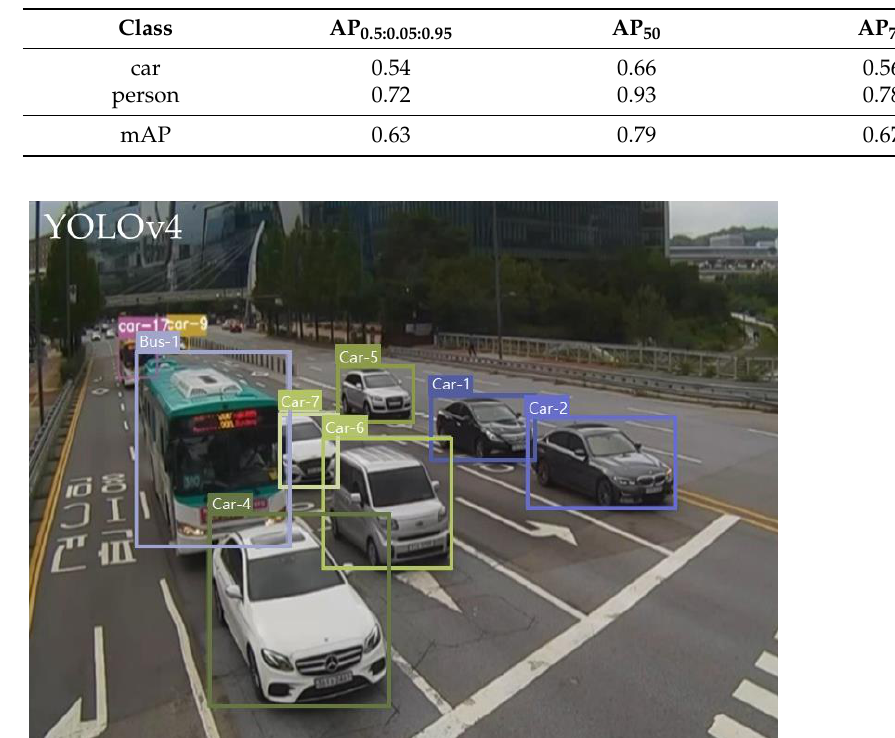
Figure 10. Sample points of the traffic surveillance camera.